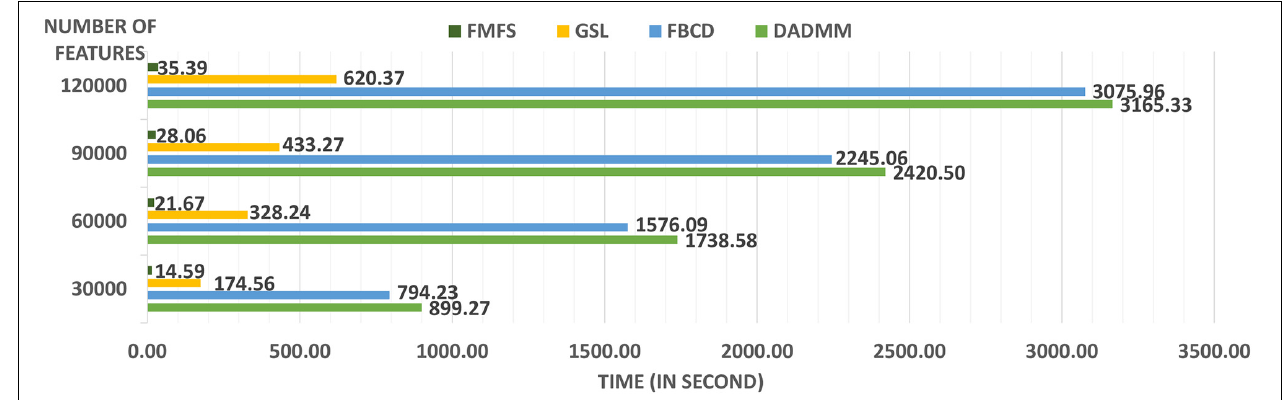
FIGURE 2 | Comparison analysis of computation efficiency. For the morphometry features with different resolutions, our framework achieves a speedup of 62–, 80–, 86–, and 89-fold, compared to DADMM. For FBCD, our FMFS has a speedup of 54–, 72–, 80–, and 86-fold. For GSL, our model has a speedup of 12–, 15–, 15–, and